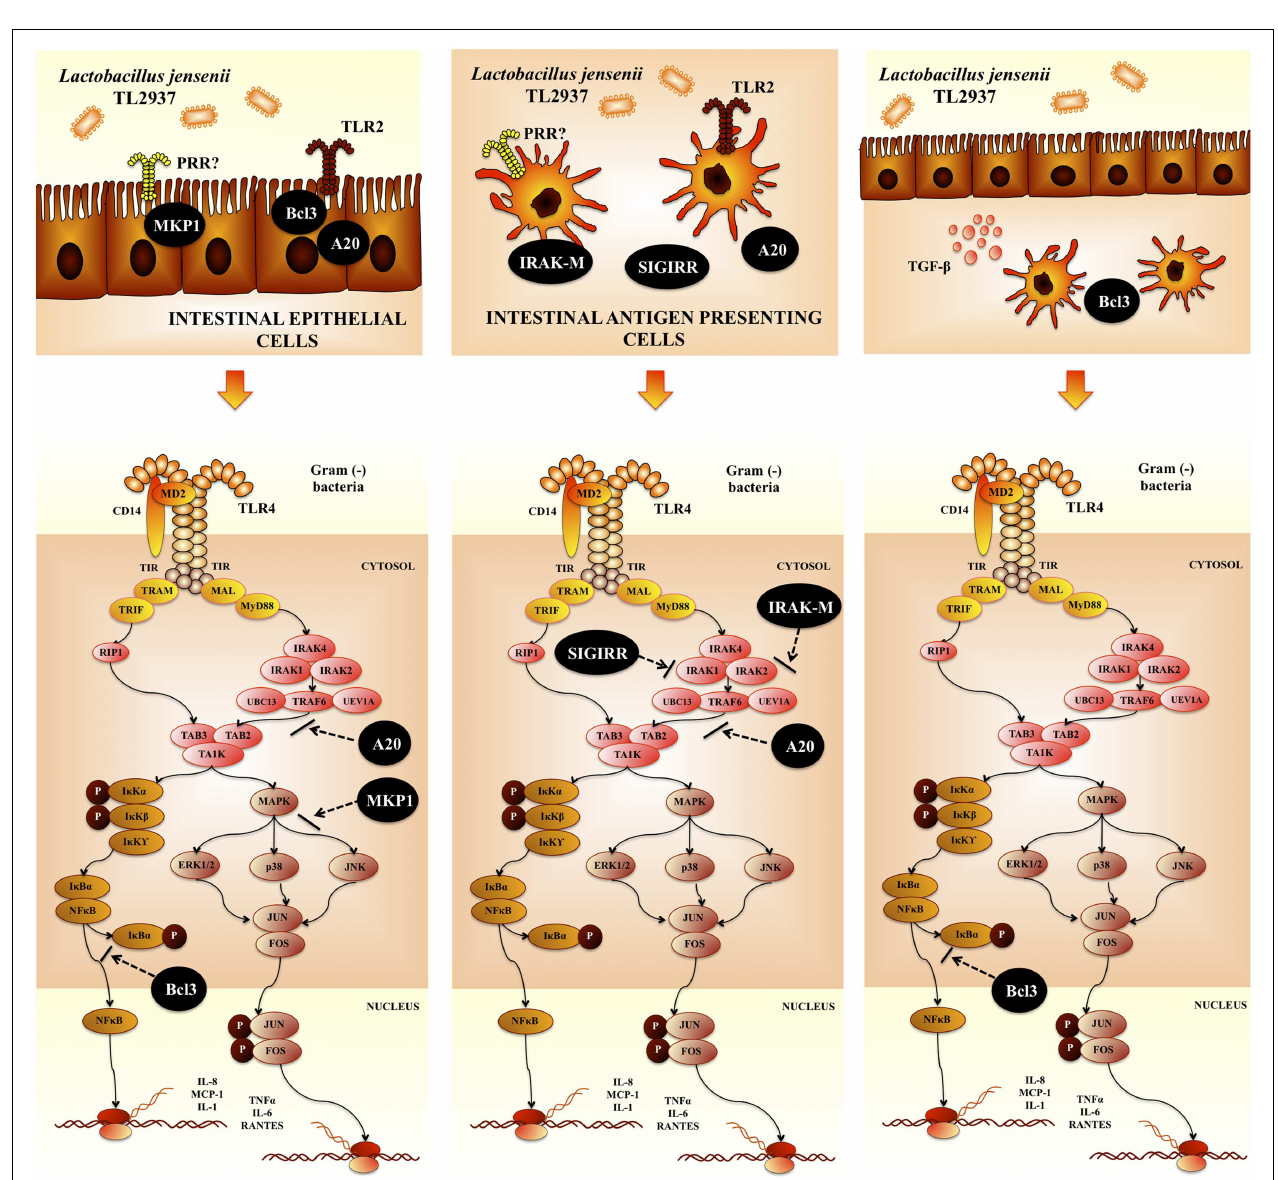
FIGURE 2 | Modulation of negative regulators of toll-like receptor-4 signaling pathway by Lactobacillus jensenii TL2937 in porcine intestinal epithelial cells and antigen presenting cells